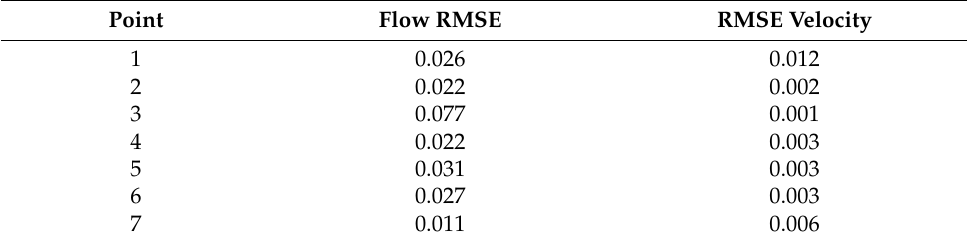
Table 4. RMSE values for velocities and flow rates in the June 2018 calibrated model. Point Flow RMSE RMSE Velocity